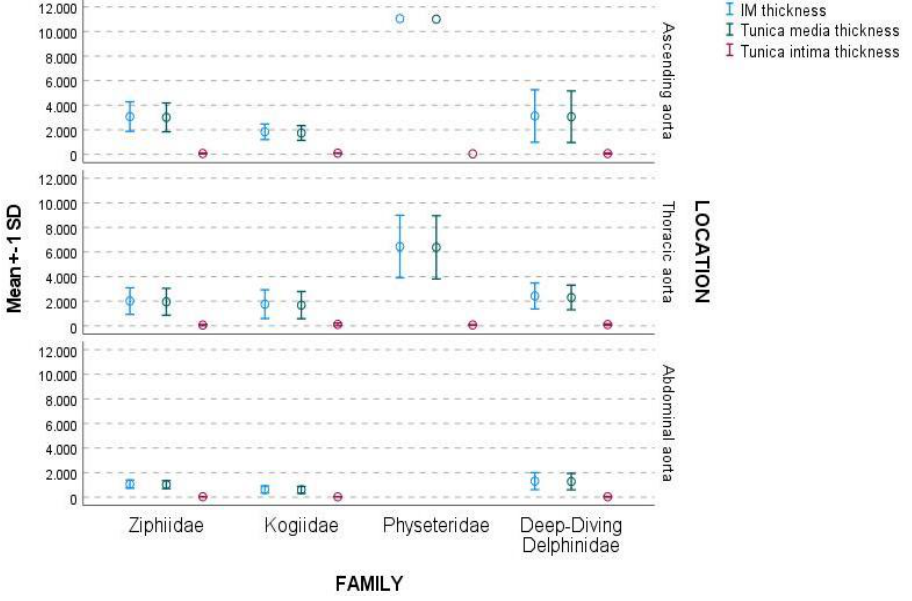
Figure 5. The graphic shows the mean ± SD thickness (μm) of the IM, tunica media, and tunica intima in the four families attending to the aortic location.